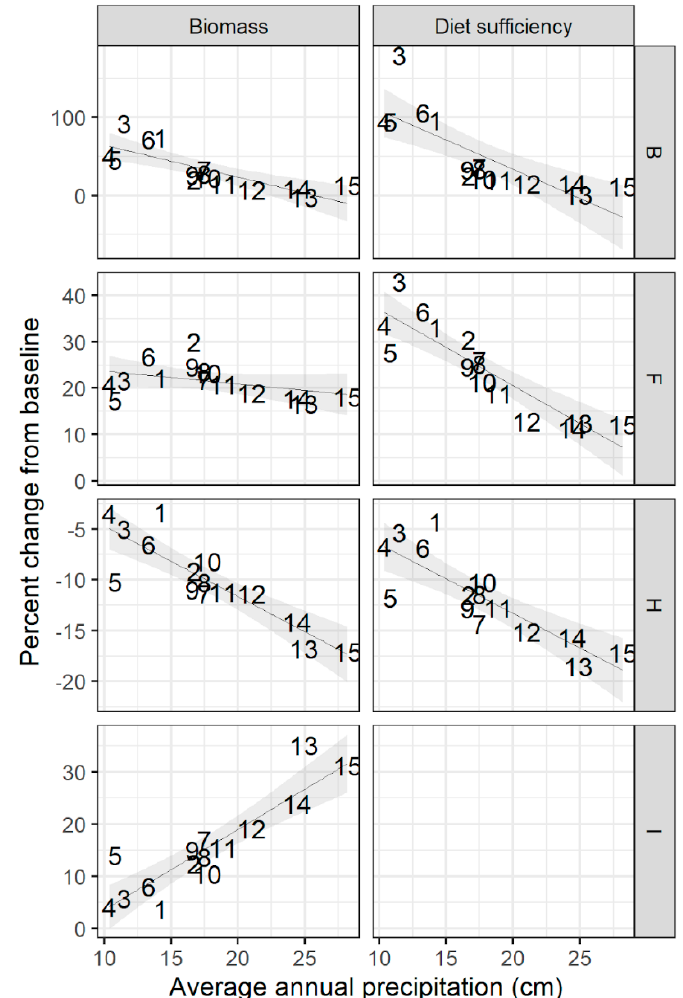
Figure A2. Percent change in standing biomass and animal diet sufficiency at 15 sites under fixed contrasts of altered temperature, precipitation, and animal density applied one-at-a-time. Contrast B: elevated temperature; F: elevated precipitation; H: elevated animal density; I: no grazing. Shaded area shows 95% confidence interval around best-fit line. Sites are shown here by their label from south (1) to north (15); see Figure 1 and Table A1 for site